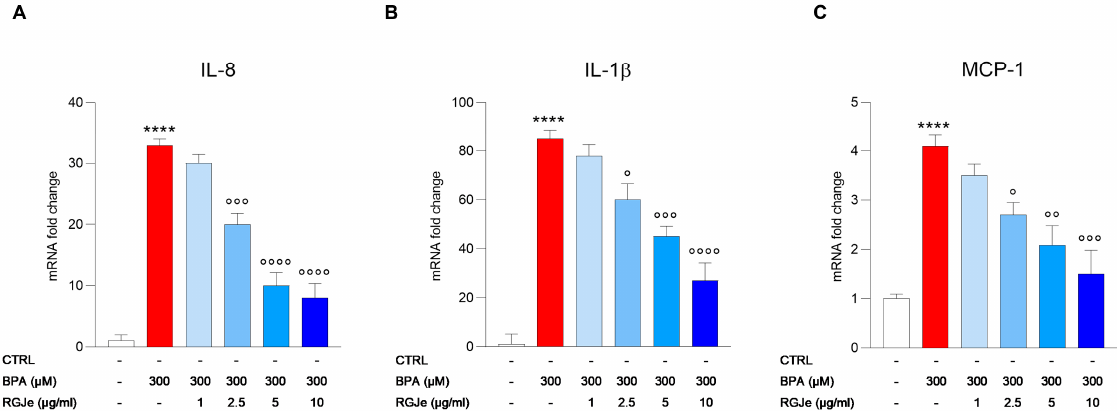
Figure 7. Effect of RGJe on IL-8 and IL-1 β cytokines and MCP-1 chemokine gene expression in BPA-treated HUVECs. The results from RT-PCR of IL-8 ( A ), IL-1 β ( B ), and MCP-1 ( C ) are expressed as an n-fold change compared to untreated cells after normalization against β -actin as endogenous control. Data represent the mean ± SEM of three different sets of experiments performed in triplicate (n = 9). **** p < 0.0001 vs. CTRL; ◦ p < 0.05, ◦◦ p < 0.01, ◦◦◦ p < 0.001, and ◦◦◦◦ p < 0.0001 vs. BPA 300 µM.